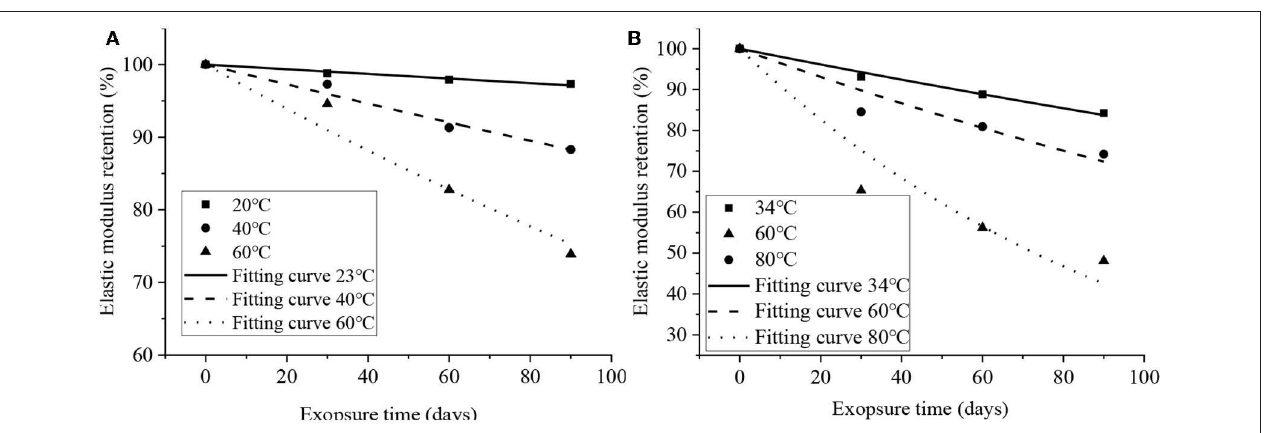
FIGURE 5 | Fitted curves for elastic modulus retention vs. time: (A) Liu et al. (2016) and (B) Zhang (2008).